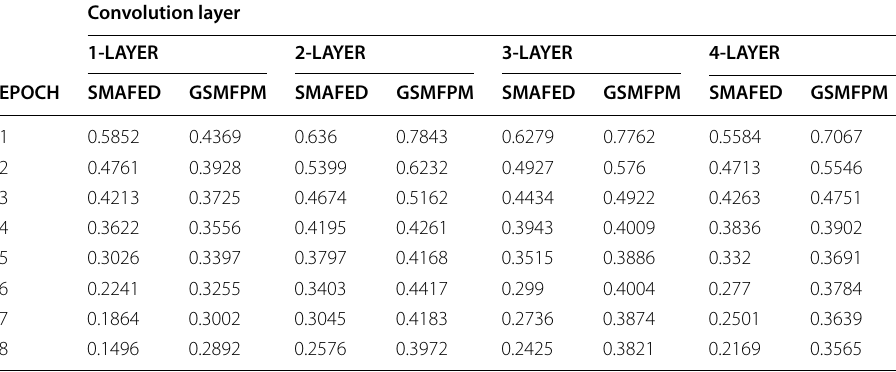
Table 12 Four-Layer convolutional neural network cross-entropy loss function for GSMFPM and SMAFED on twitter sentiment analysis training